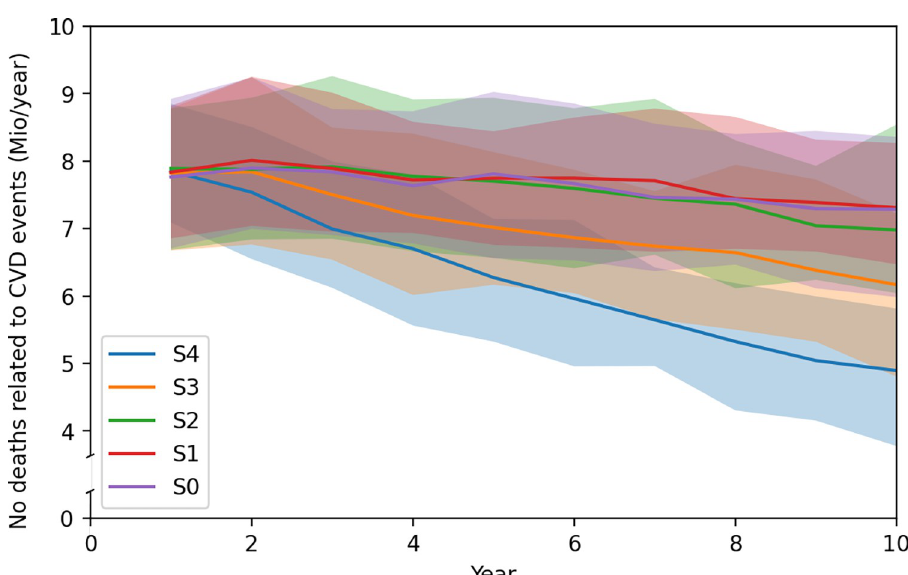
Fig 4. Mean numbers of deaths related to HTN-induced CVD events per year and their 95% credible intervals for the different scenarios for the population of LMICs (S0: Base case, S1: Lower accuracy, S2: Improved accuracy, S3: Increased coverage, S4: Increased coverage and screens completed). CVD, cardiovascular disease; HTN, hypertension; LMIC, low- and middle-income country.